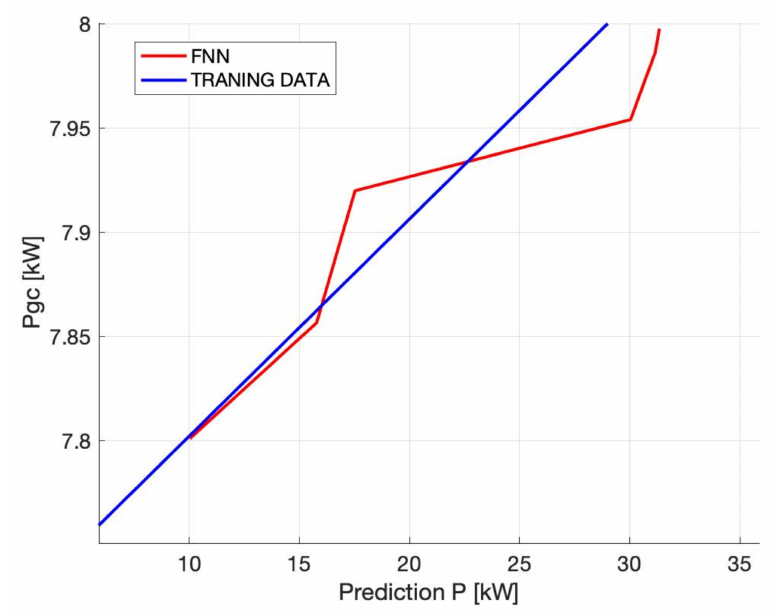
Figure 22. Compilation of the training data with the machine response, scenario